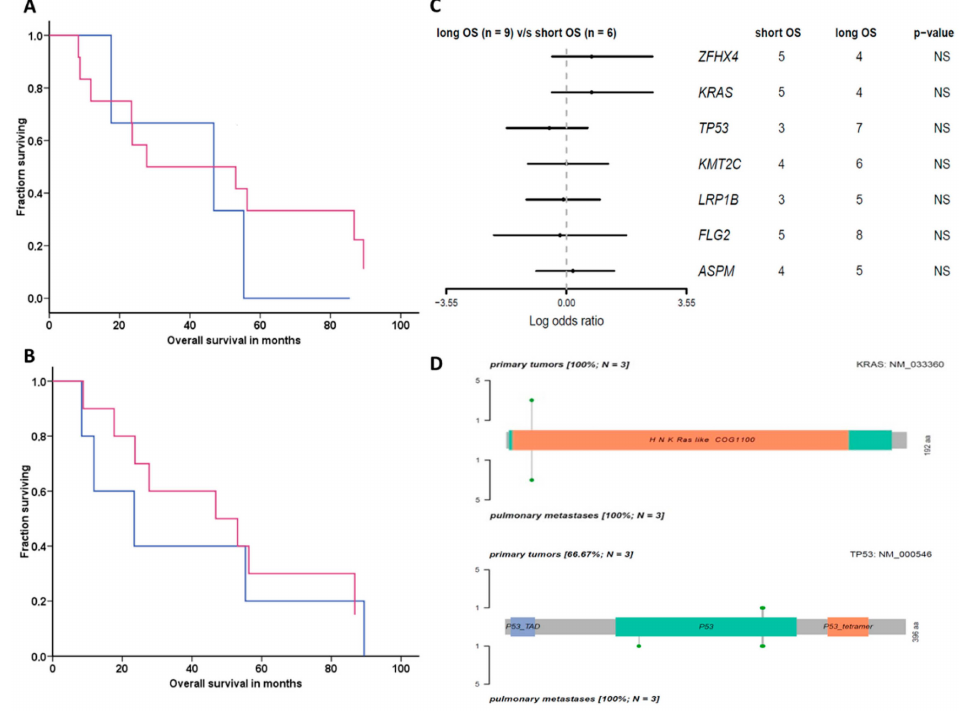
Figure 3. Association of KRAS and TP53 mutations with survival and metastases. ( A ) Associations of KRAS and ( B ) TP53 mutations with survival: red lines for mutated and blue lines for wild type. ( C ) Forest plot showing odds ratios of genes conferring shorter overall survival. ( D ) Lollipop plot comparison of mutations in primary tumors and metastases: KRAS , the longest transcript (192 amino acids) is shown (left); TP53 , the longest transcript (396 amino acids) is shown (right). Left axes show the number of samples with mutation hit. Missense mutations are depicted in green